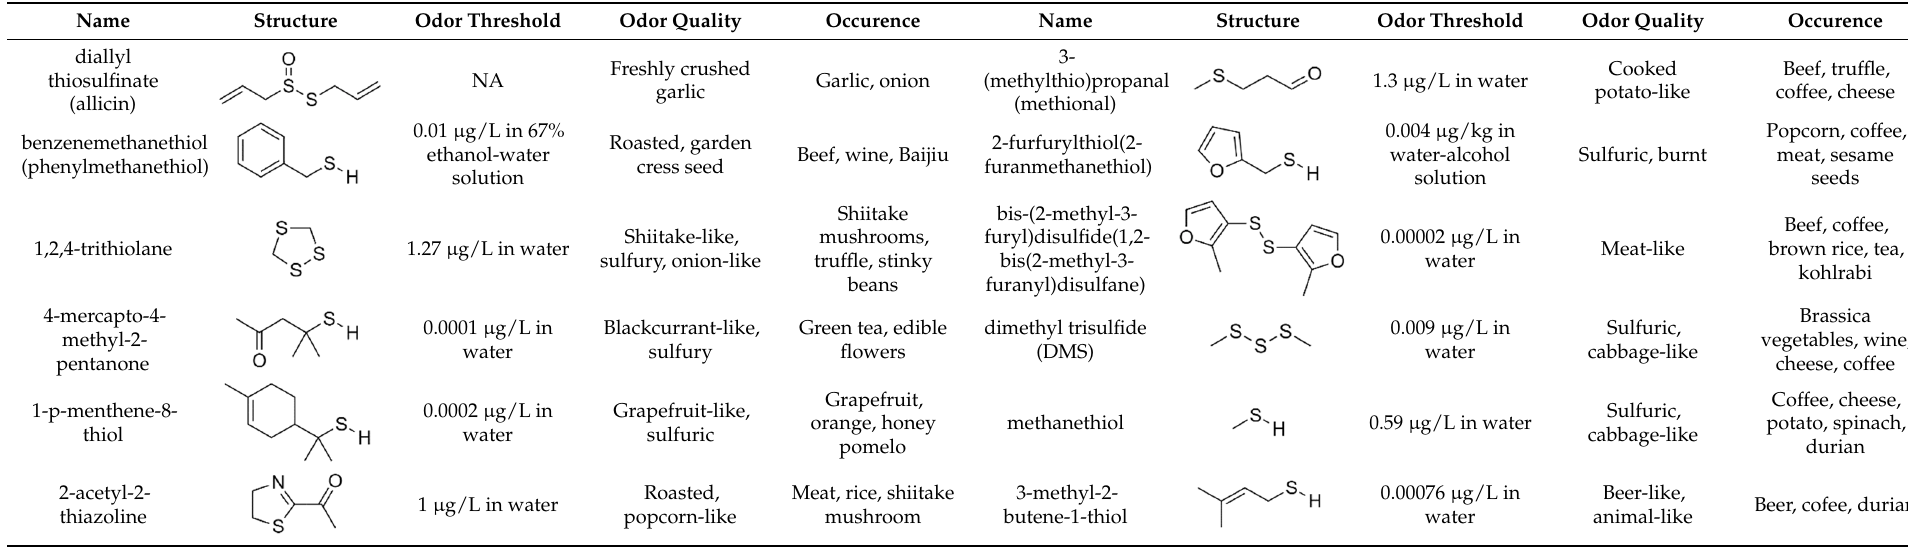
Table 1. Selected sulfur key odorants in food formed in enzymatic and chemical (mainly thermal) reactions.